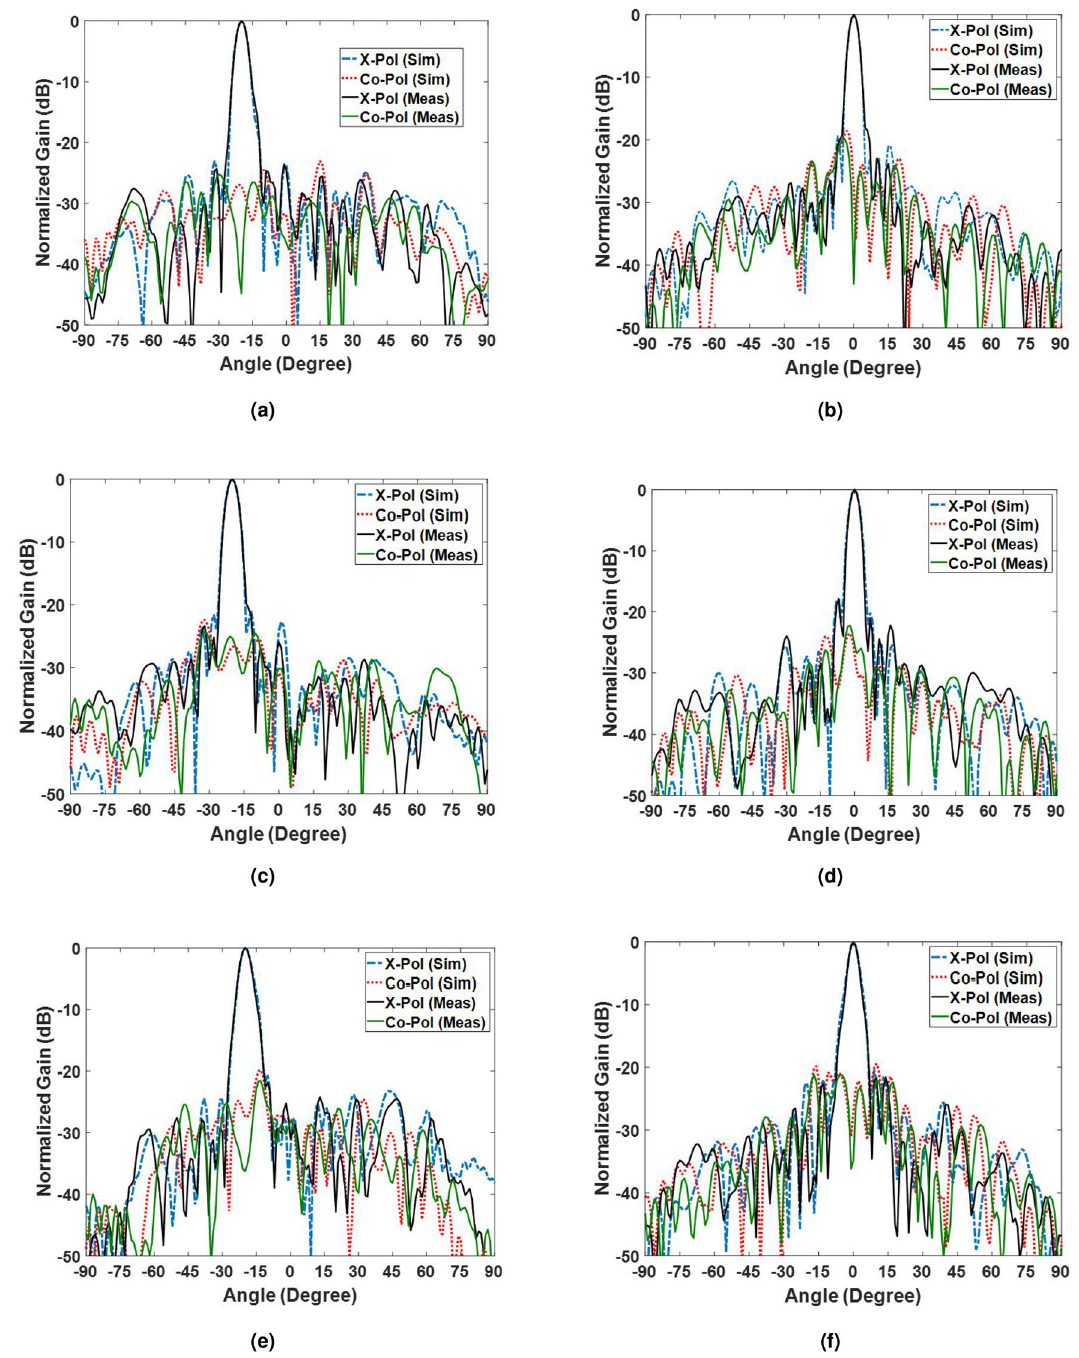
Figure 14. Comparison of the simulation and measurement results. ( a ) E-plane at 14 GHz, ( b ) H-plane at 14 GHz, ( c ) E-plane at 17 GHz, ( d ) H-plane at 17 GHz. ( e ) E-plane at 19 GHz. ( f ) H-plane at 19